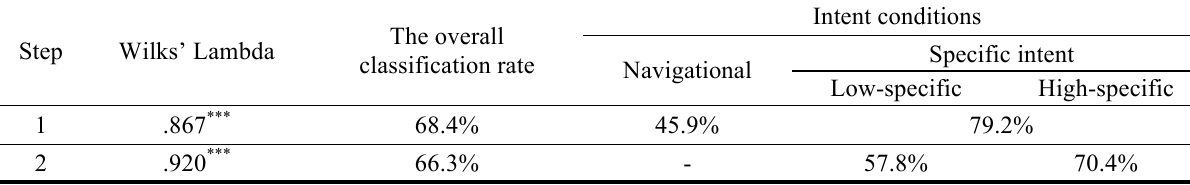
Table 2. Classification rates for each step of the discriminant analysis Step